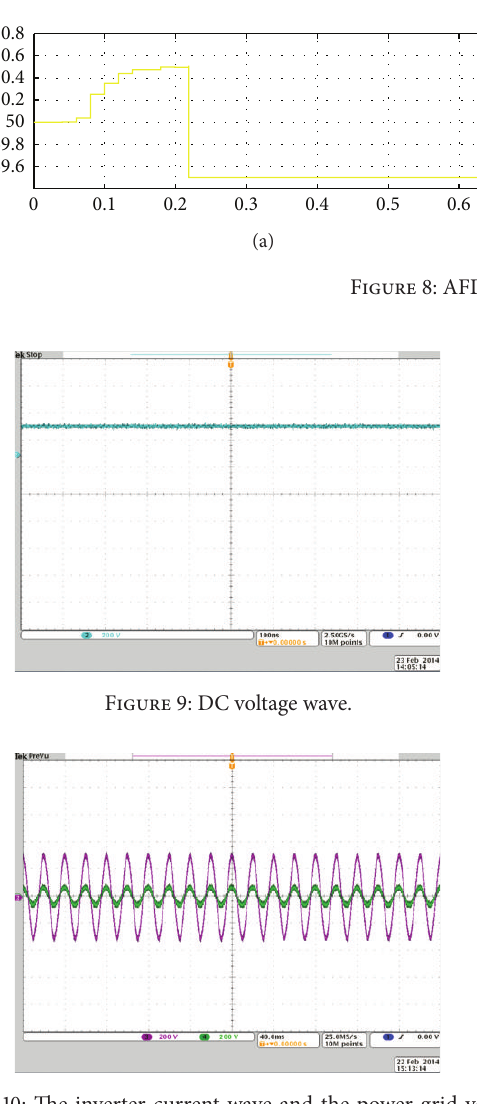
Figure 10: The inverter current wave and the power grid voltage